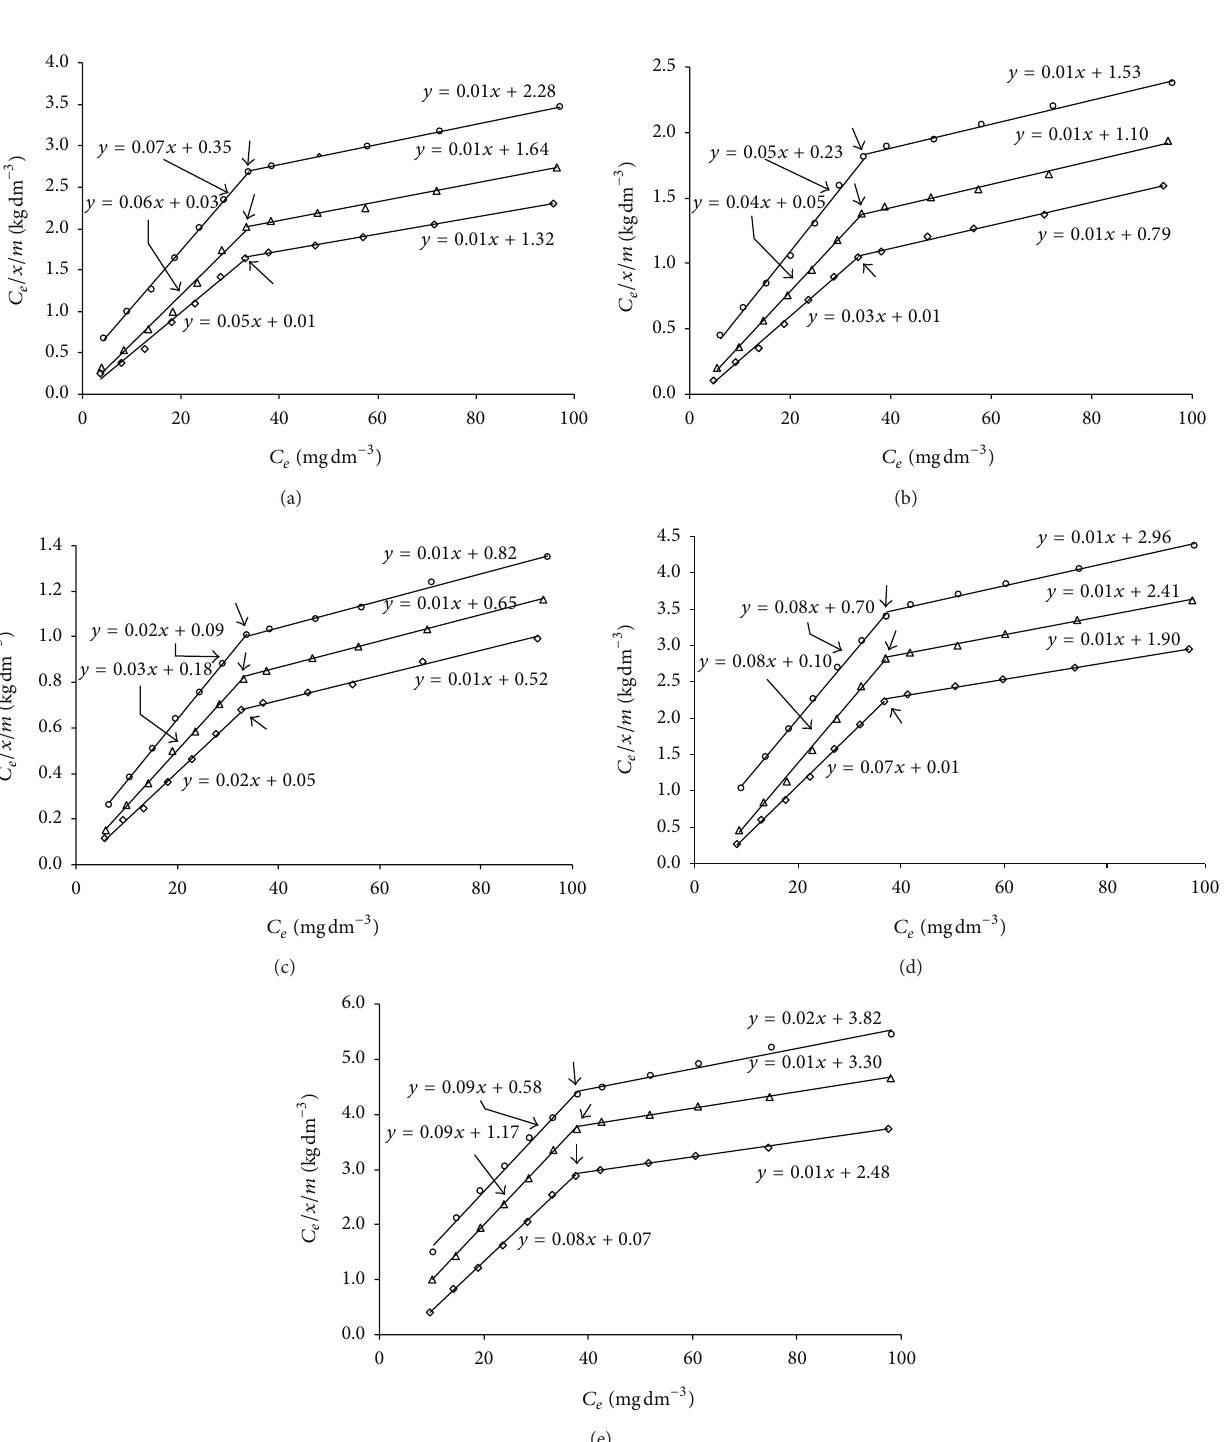
Figure 3: Isotherm for the sorption of added Cd by the soils obtained using the conventional Langmuir equation; breaks in the isotherms are indicated by arrows and line of each plot represents modified Langmuir equation. (a) S 1 , (b) S 2 , (c) S 3 , (d) S 4 , and (e) S 5 . - ∘ -, - 󳵻 -, and - ◊ - for 25, 35, and 45 ∘